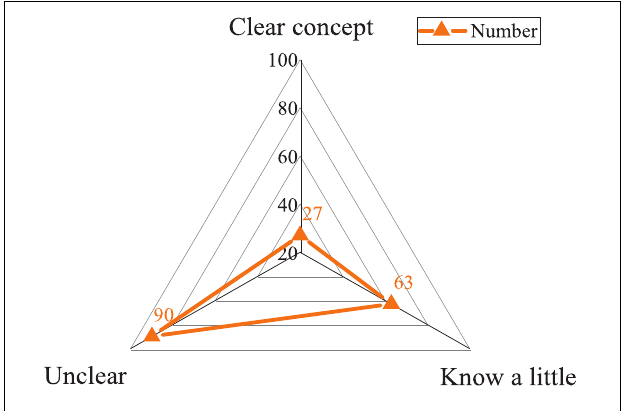
FIGURE 4 | Students’ ideological cognition of deep